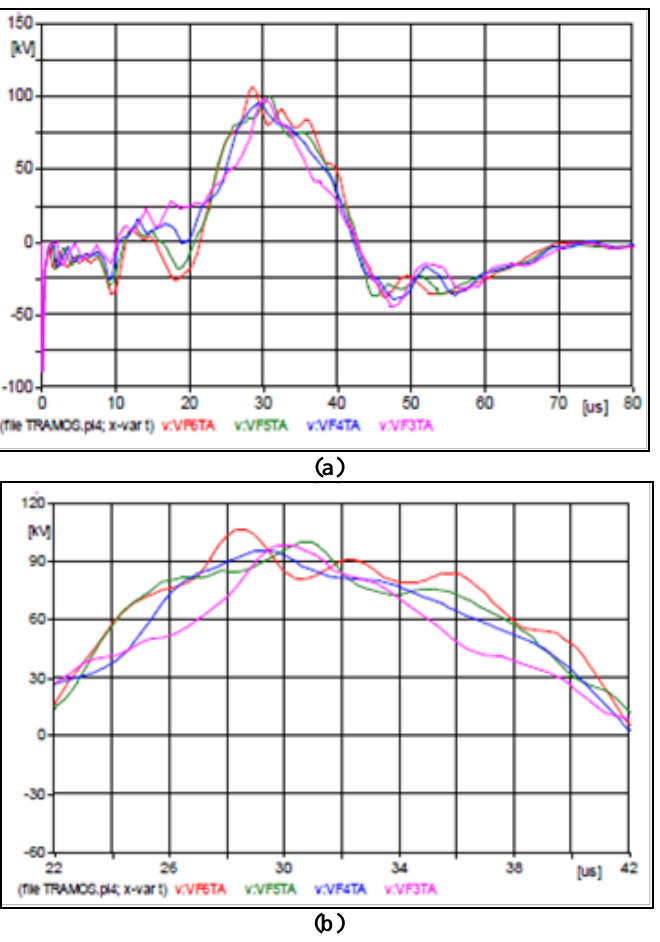
Figura 7: Detalle de la respuesta del modelo consolidado de línea ante una perturbación tipo descarga atmosférica, en la fase A del extremo de una línea que fue modelada mediante 3,4,5 y 6 tramos (VF3TA, VF4TA, VF5TA y VF6TA, respectivamente). (a) Respuesta completa (0-80 µs). (b) Detalle en el pico de tensión obtenido (22-42 µs) Fuente: Los Autores, (2017).